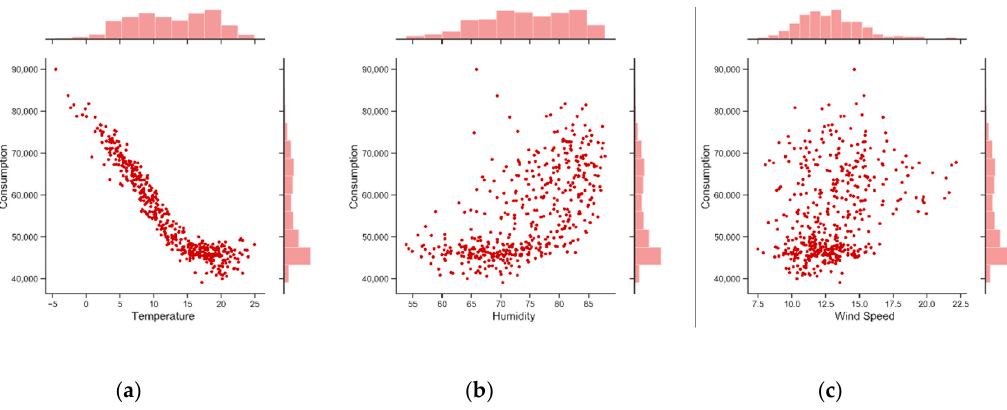
Figure 8. Joint plot of electric load vs. ( a ) temperature ( b ) humidity ( c ) wind speed.